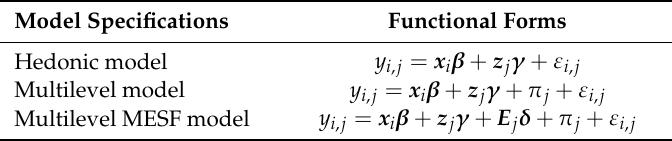
Table 2. Model specifications and their functional